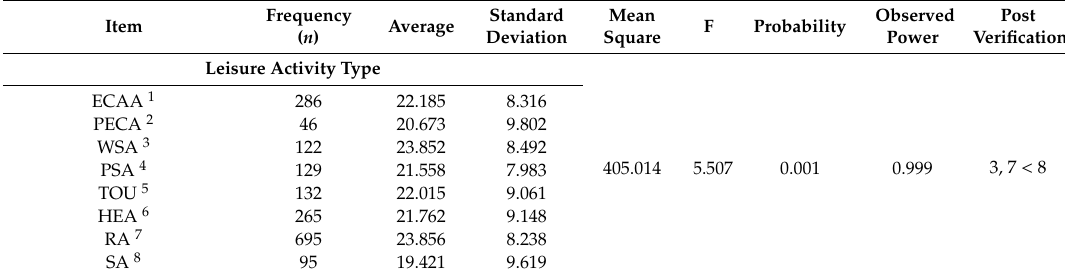
Table 3. Di ff erences in psycho-social health based on participation in leisure